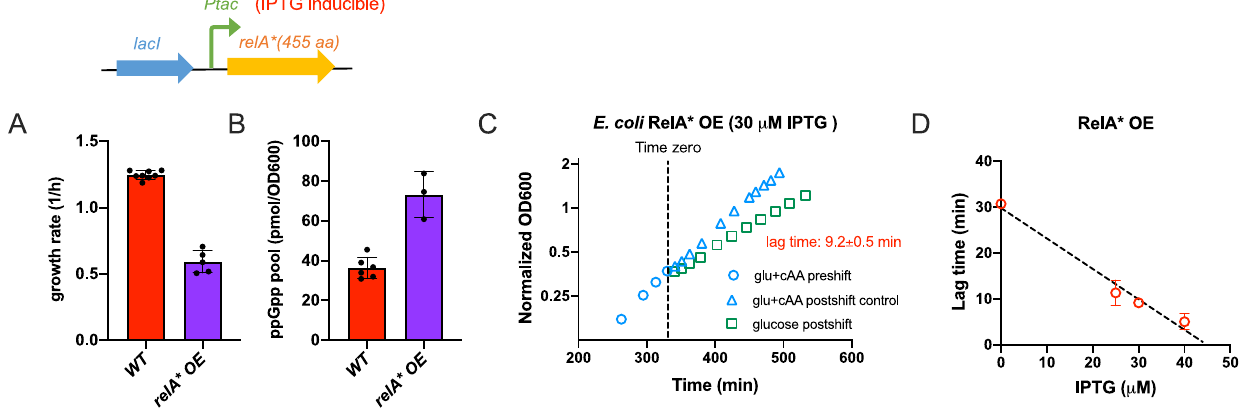
Fig. 2 | Growth adaption of E. coli to AA downshift during elevated (p)ppGpp level. E.coli wastransformedwithpLAS13plasmids,inwhichaconstitutivelyactive relA * (encoding the N-terminal 1-455 aa of native relA ) was driven by the IPTG- inducible Ptac promoter. A Effectof relA *overexpression(OE)onthegrowthrateof E. coli in glucose cAA medium. IPTG was added at a concentration of 30 µ M. Error barsarethestandarddeviationsofseveralbiologicalreplicates( n =8and5forwild type and relA * OE, respectively). B Effect of relA * overexpression on the cellular ppGpp pools of E. coli in glucose cAA medium. IPTG was added at a concentration